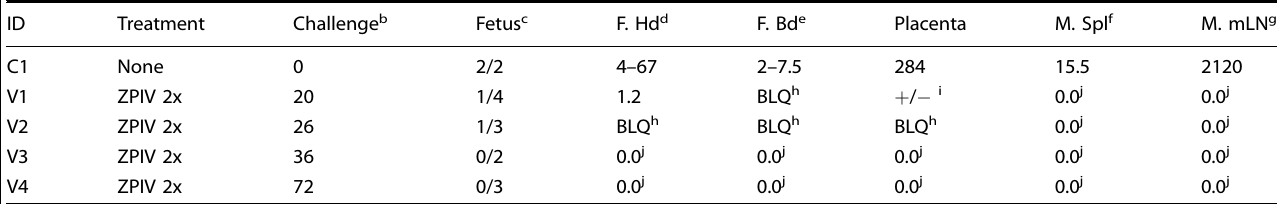
Table 1. ZIKV RNA loads in maternal and fetal tissues in marmosets a .